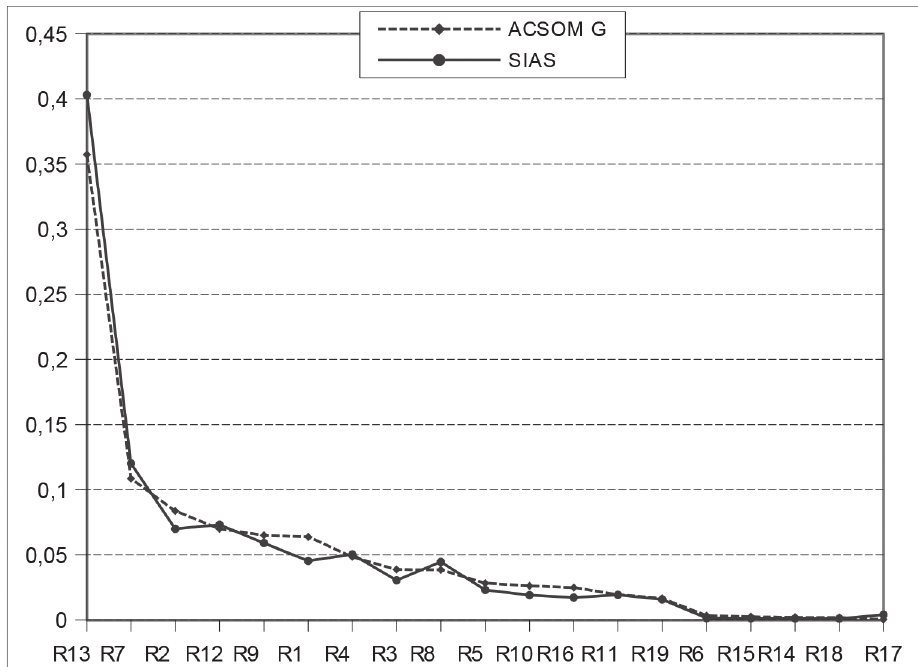
Figure 1 - SIAS vs ACSOM G Polygonal Lines.